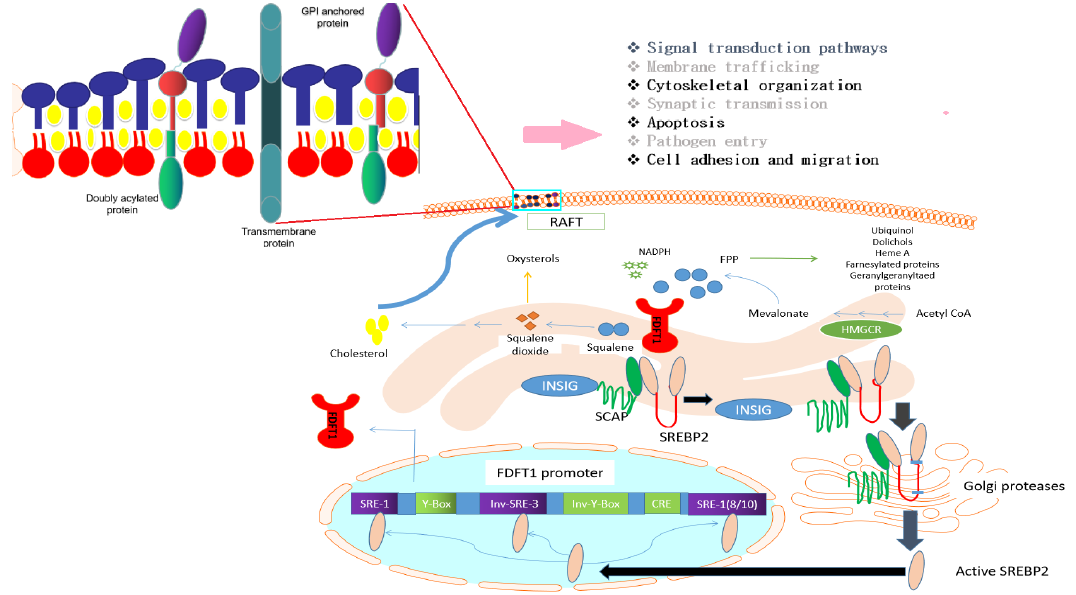
Figure 1. Role of FDFT1 in the biosynthesis of cholesterol, structure and roles of lipid rafts and regulation of FDFT1 by SREBP2. FDFT1 is the first enzyme of the cholesterol biosynthesis branch, as FDFT1 converts farnesyl pyrophosphate (FPP) into squalene which ultimately produces cholesterol and cholesterol derivatives. Therefore, inhibition of FDFT1 only impacts the cholesterol biosynthesis pathway but not an alternative pathway, where FPP is converted into other essential cellular products such as ubiquinol, dolichols, heme A, farnesylated proteins, or geranylgeranylated proteins. Cholesterol is one of the most critical components of the plasma membrane microdomain known as rafts. Beyond cholesterol, the raft is structured by transmembrane proteins, doubly acylated proteins, and glycosylphosphatidylinositol (GPI) anchored proteins. Lipid rafts contribute to a variety of cellular biological processes such as signal transduction pathways, membrane trafficking, cytoskeletal organization, synaptic transmission, apoptosis, pathogen entry, cell adhesion, and migration. One of the key transcriptions factors of FDFT1 is SREBP2. SREBP2 is located in the endoplasmic reticulum (ER) membrane as an inactive form which is bound with Insulin Induced Gene 1 (INSIG) and Sterol Regulatory Element-Binding Protein Cleavage-Activating Protein (SCAP). Upon specific signals such as cholesterol deprivation, PI3K/AKT/mTOR, hypoxia, low pH, androgens, or ER stress, SREBP2 is activated by removal of INSIG from the complex INSIG-SCAP-SREBP2, and then SCAP-SREBP2 is transported to the Golgi, where SREBP2 is cleavage by Golgi proteases to form active SREBP2. The active SREBP2 form translocates into the nucleus and binds to SRE regions in the FDFT1 promoter including sterol regulatory element (SRE)-1, Inv SRE-3, and SRE-1 (8/10), which results in transcription of FDFT1.